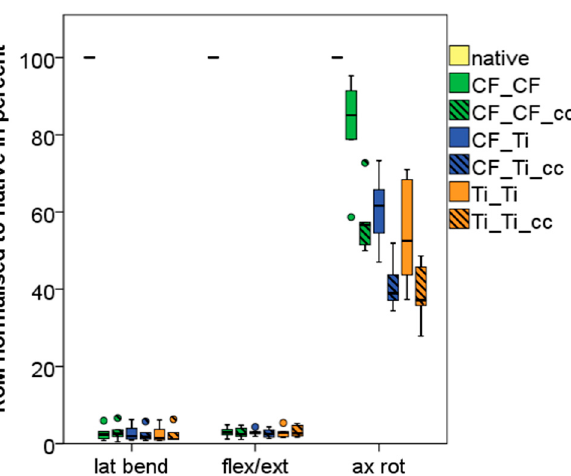
Figure 5. Boxplot showing the median and quartiles of the index segment for all tested states in the three motion directions normalized in percentage of the native state.